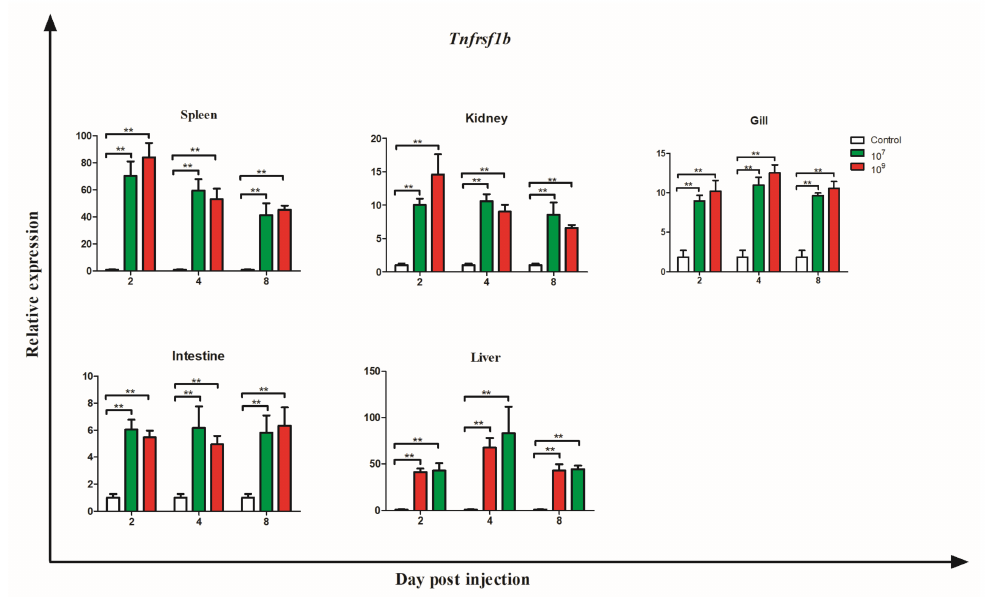
Figure 9. Expression analysis of tnfrsf1b after infection with K. peneumoniae . Fish were i.p. injected with 0.1 mL 1 × 10 7 or 1 × 10 9 CFU/mL K. pneumoniae suspension. Ef-1 α was used as an internal reference gene for normalization of gene expression. The expression levels of genes were compared with that of the control group (defined as 1). Bars represent mean + SEM ( n = 5). Significant differences are indicated by ** ( p < 0.01).